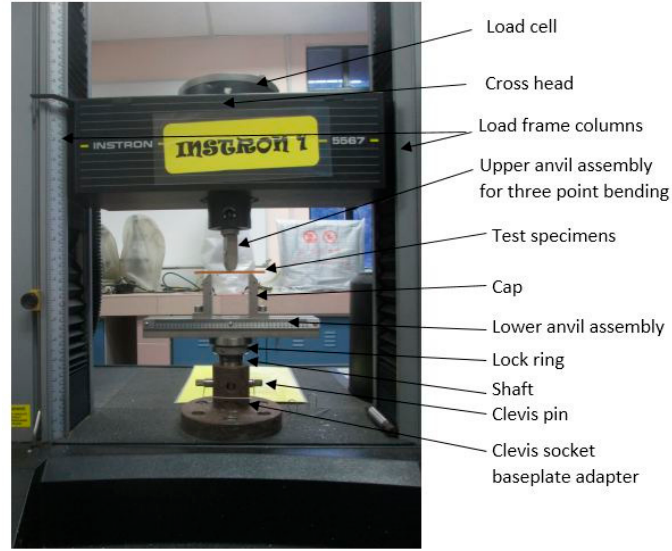
Figure 3. Flexural test setup.